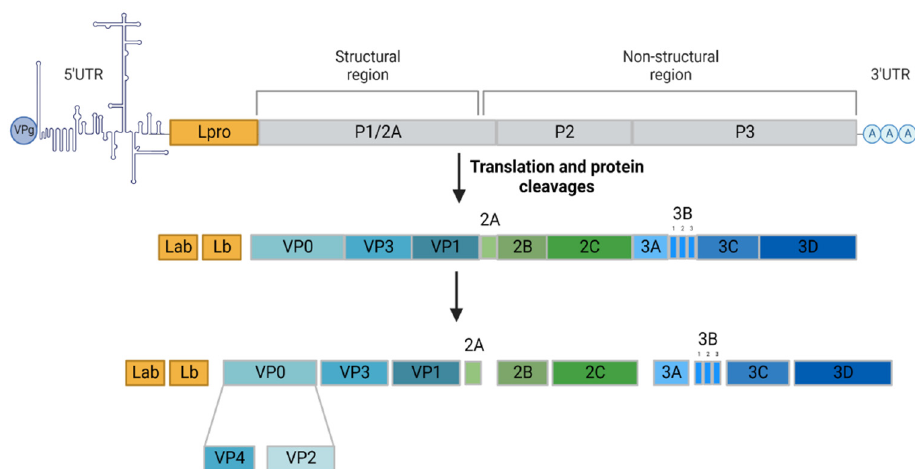
Figure 1. Foot-and-mouth disease virus genome structure and viral protein expression. The FMD virus has a small genome (about 8.5 kb) encoding four structural proteins, VP4, VP2, VP3 and VP1, forming the capsid, and eleven nonstructural proteins, Labpro, Lbpro, 2A, 2B, 2C, 3A, 3B1, 3B2, 3B3, 3C and 3D, responsible for the infectious cycle. Adapted with permission from Belsham et al., 2020 [2]. Created with BioRender.com (accessed on 16 August 2022).